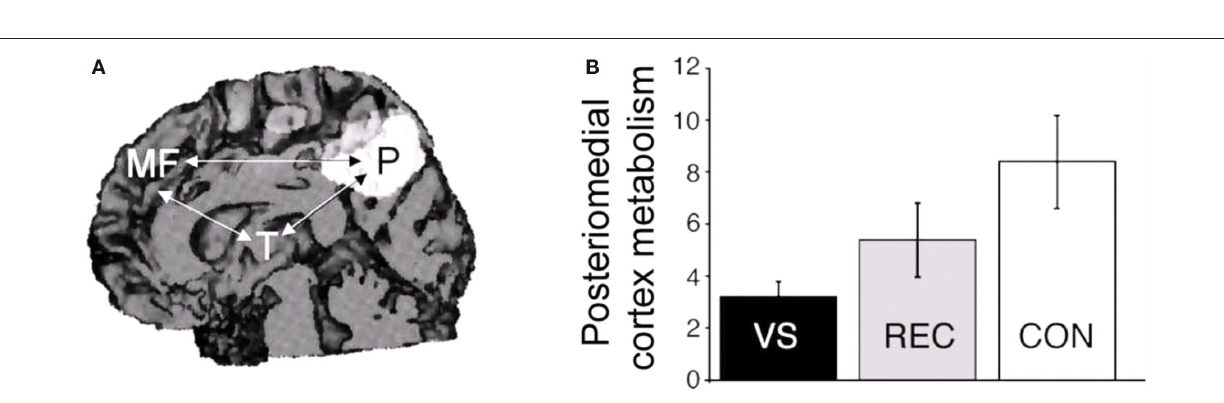
Figure 5 | (A) Restoration of glucose metabolism in posteriomedial cortices after recovery from the VS/UWS (area in white; arrows indicate the functional disconnections observed in VS/UWS patients). (B) In the same posteriomedial area, lower metabolism was observed in VS/UWS patients (black bar) as compared to those who recovered consciousness (gray bar) and to healthy controls (white bar), suggesting its critical role in the mediation of conscious awareness. Scale represents cerebral metabolic rates for glucose uptake (in mg/100 g/min). Adapted from Laureys et al.